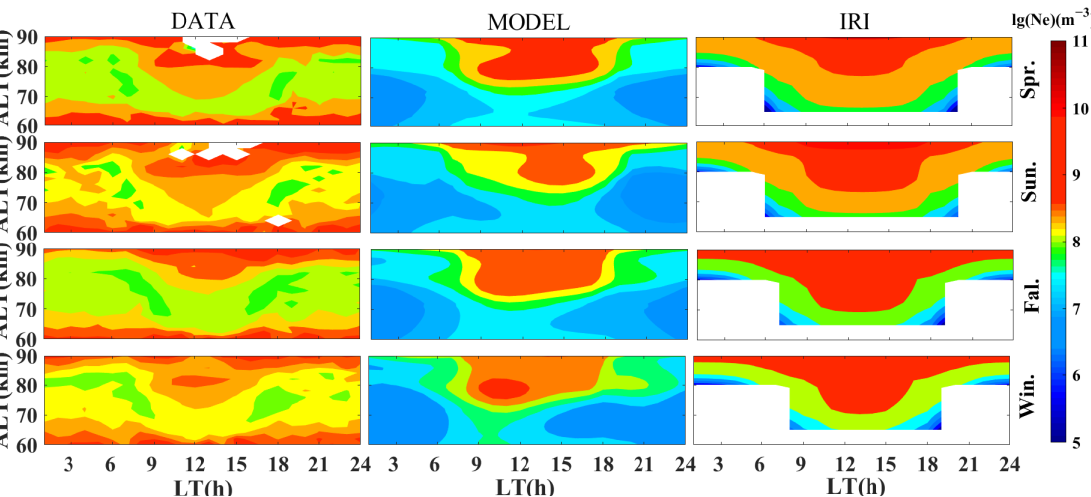
Figure 8. Daily variation of the electron density of the model, IRI, and data in the low solar activity year.